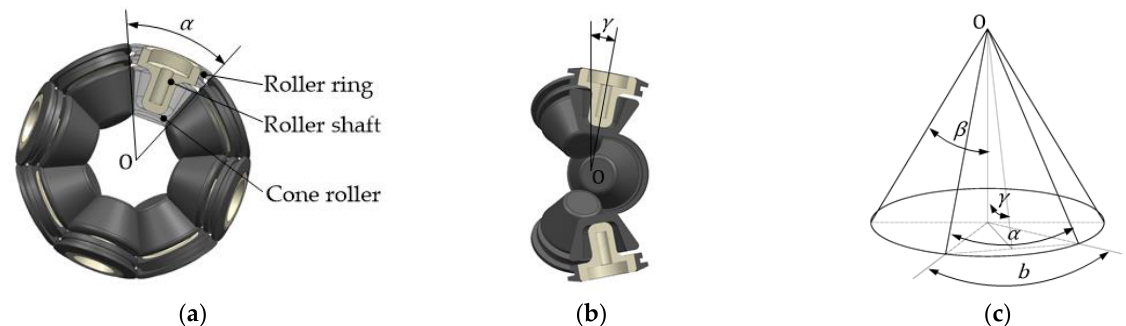
Figure 3. Structure principle of the stacked roller set: ( a ) front view of the stacked roller set; ( b ) side view of the stacked roller set; ( c ) projection of the cone roller.